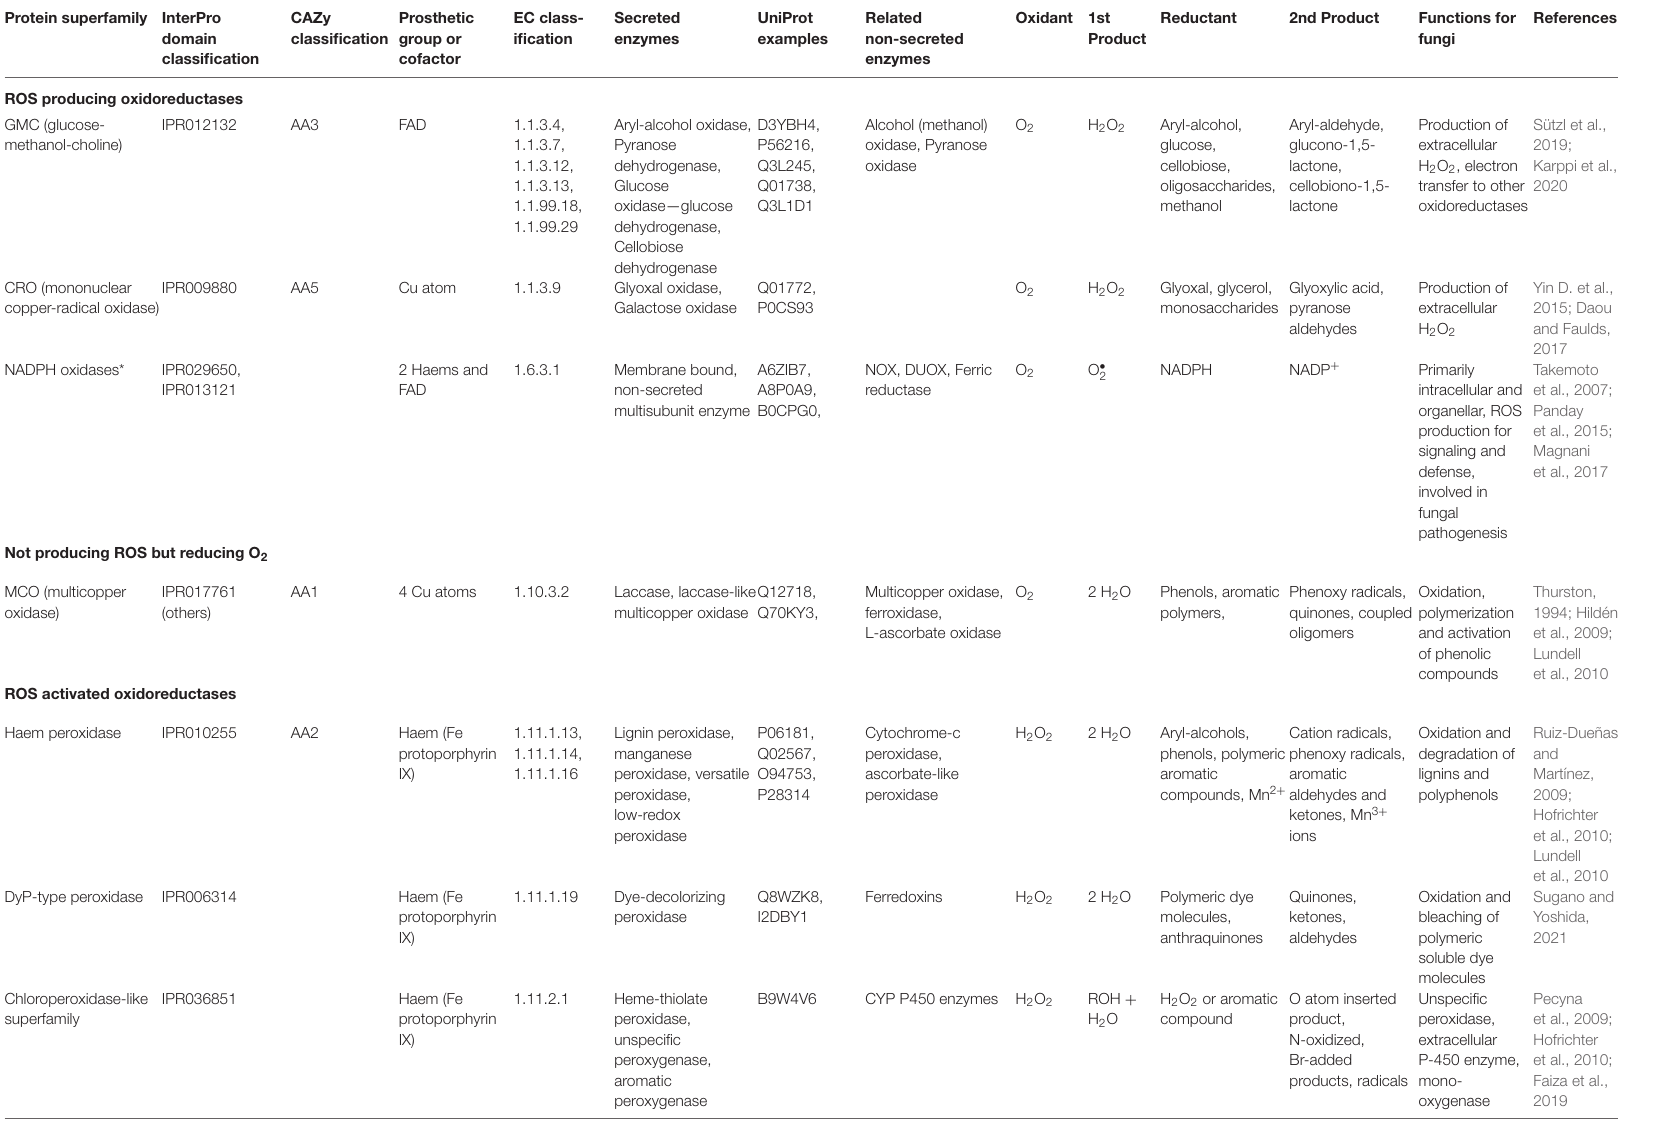
TABLE 1 | Extracellular ROS enzymes and reactions in Basidiomycota